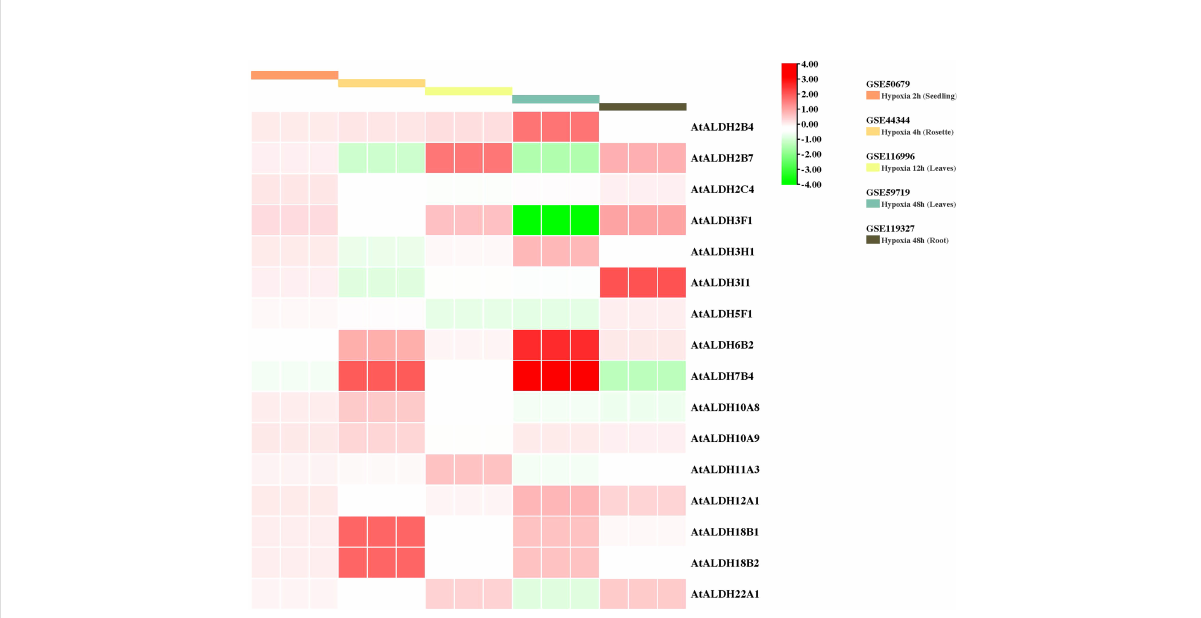
FIGURE 9 Gene expression pro fi les of AtALDH genes in Arabidopsis under hypoxia stress. The microarray datasets used in this analysis are presented in coloured rectangular boxes. Five microarrays related to hypoxia stress in Arabidopsis were extracted from the GEO database (https://www.ncbi. nlm.nih.gov/geo/ ), GSE50679 (Arabidopsis seedling with 2h hypoxia treatment); GSE44344 (Arabidopsis rosette with 4h hypoxia treatment); GSE116996 (Arabidopsis leaves with 12h hypoxia treatment); GSE59719 (Arabidopsis leaves with 48h hypoxia treatment); and GSE119327 (Arabidopsis root with 48h hypoxia treatment). The scale of the graph represents the log fold change value for the AtALDH